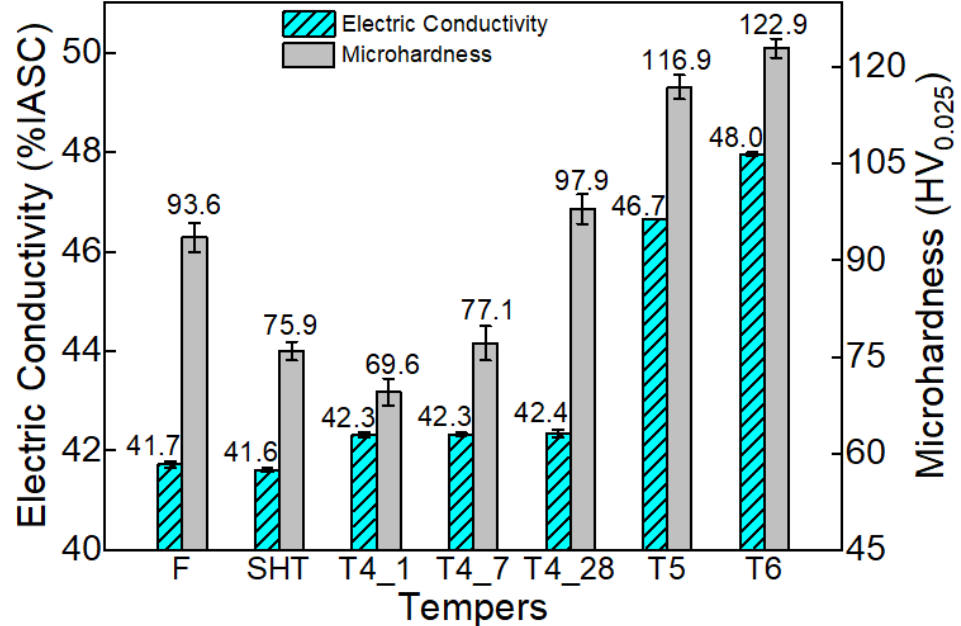
Figure 11. Evolution of EC and Vickers hardness of the Al-Mg-Si AA6082 alloys after various treatments .